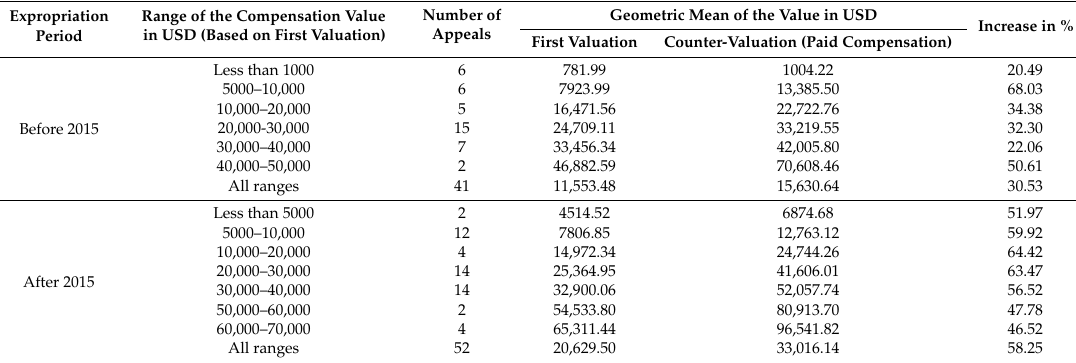
Table 4. Variation in compensation values, based on first and counter-valuation. Expropriation